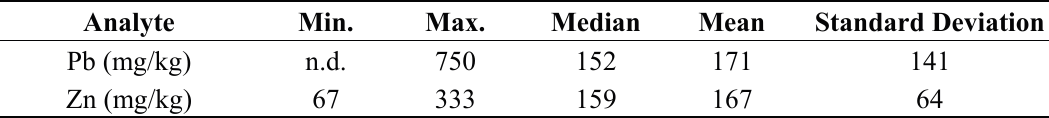
Table 2. Summary of elemental concentrations of soil samples collected in Sacramento, CA and analyzed by portable XRF. n.d. = not detected (less than 15